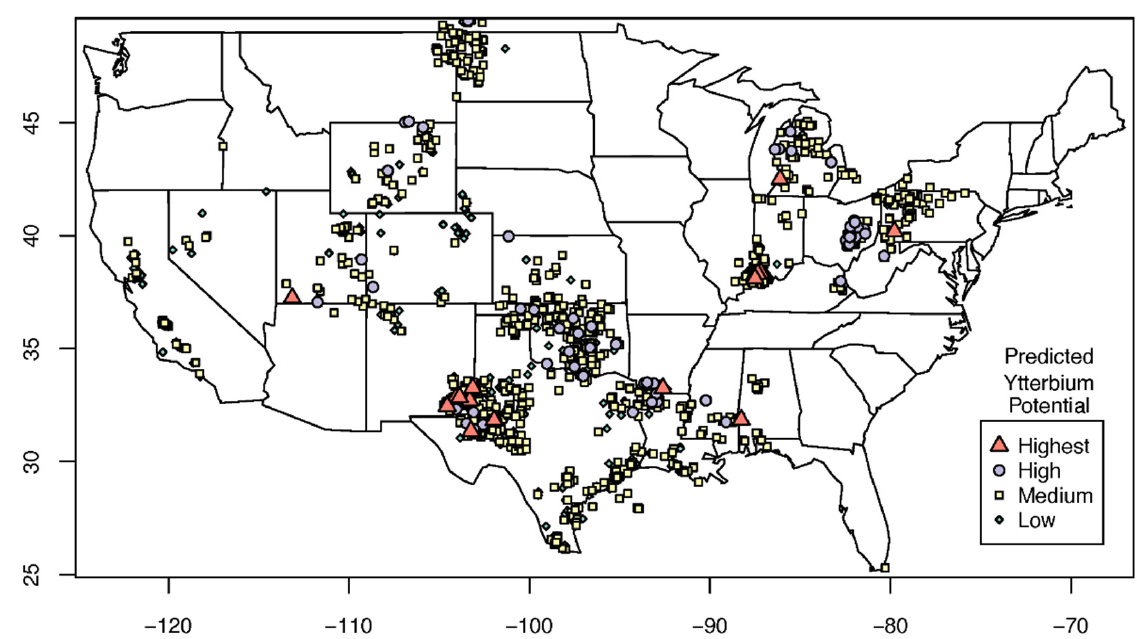
Figure 8. Predicted Yb potential of produced and geothermal waters. Predicted potential categories: highest ≥ 125, high = 50–124, medium = 1–49, low < 1.